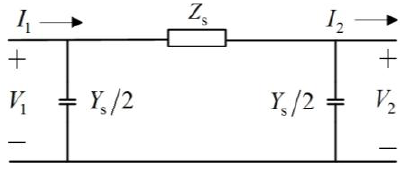
Figure 4. Single-phase PI-circuit.